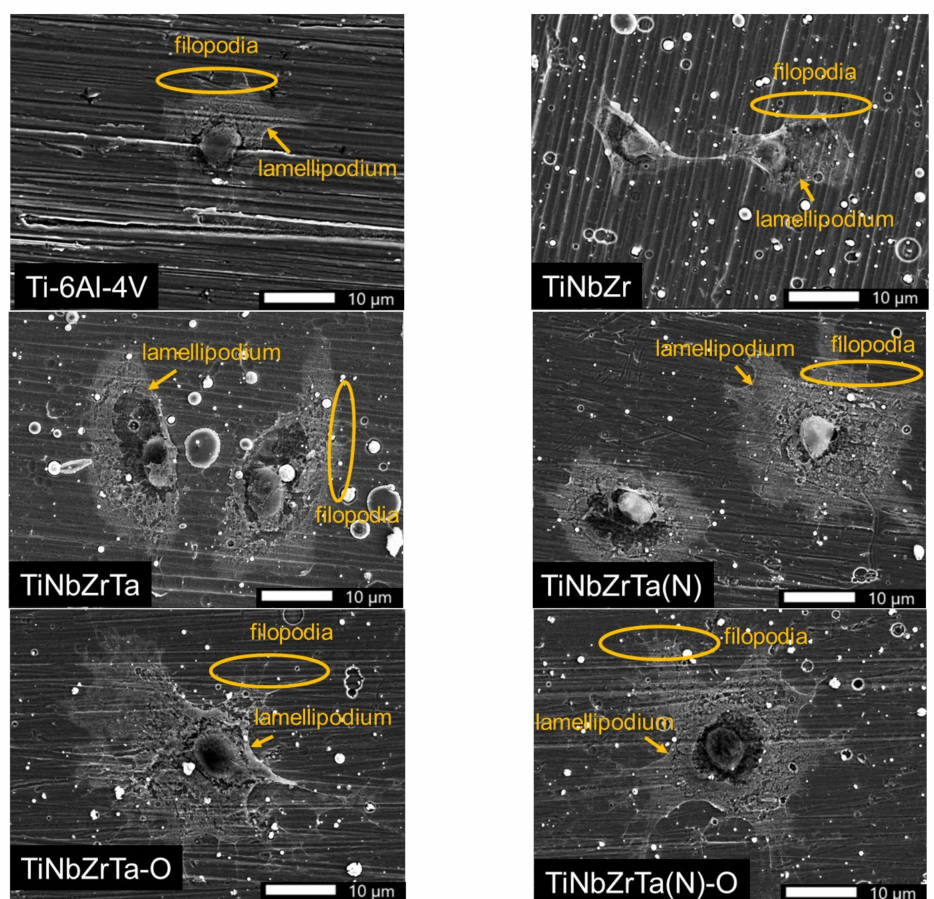
Figure 9. SEM images of L-929 cells cultured on Ti-6Al-4V, TiNbZr, TiNbZrTa, TiNbZrTa(N), TiNbZrTa-O, and TiNbZrTa(N)-O for 48 h. The scale was 10 µ m (1000 × magnification from the raw images). The arrows indicate lamellipodia, and the circles indicate